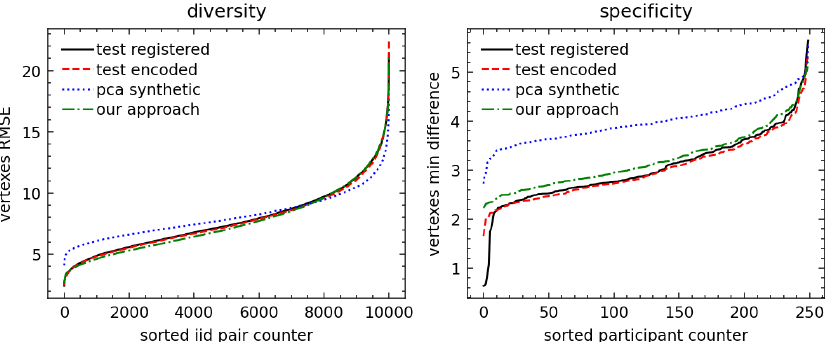
Figure 8. The face metrics. On the left, the diversity is plotted for each i.i.d pair and shows that the PCA distribution is “flatter”, as excepted when using the linear method. On the right, the specificity (the minimum distance versus the training set was kept) shows that our approach is much closer to the test set. Moreover, the specificity also proves that we did not replicate the input training scans since the minimum distance was markedly above 0 mm—with our approach above 2 mm.